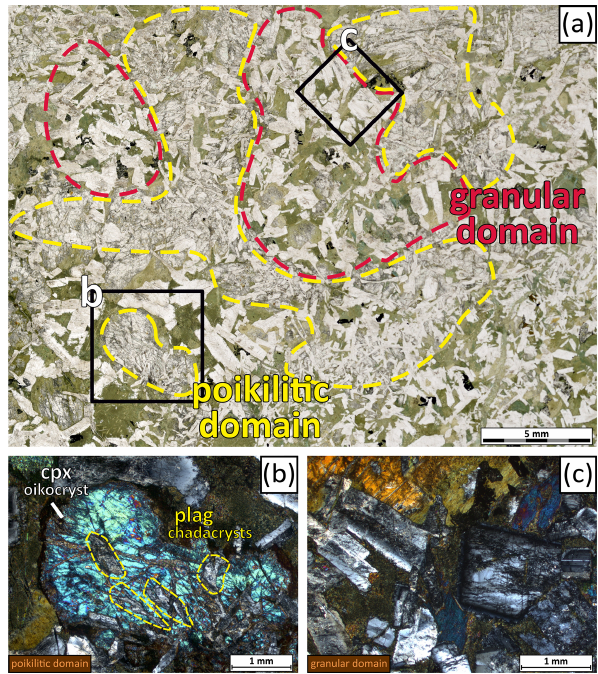
Figure 4. (a) Thin-section photo of varitextured gabbro GT3A- 55Z-4, 38–43cm; plane-polarized light. Poikilitic and granular do- mains are highlighted. The marked boxes represent details shown in (b) and (c) . (b) Poikilitic texture: lath-shaped plagioclase (plag) chadacrysts are enclosed by clinopyroxene (cpx) oikocrysts; cross- polarized light. (c) Granular texture: assemblages of tabular plagio- clase and hornblende; cross-polarized